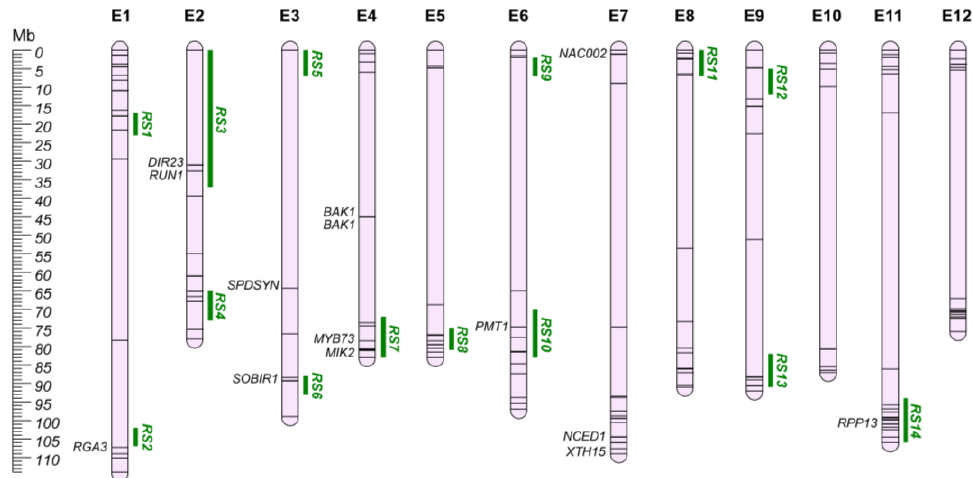
Figure 6. Pathogen resistance QGRs (RS; Green) and pest resistance chromosome map (E1 – E12). Main candidate genes are reported in italics, while information about the other candidates (represented by bars on the chromosomes) are shown in Table S3.